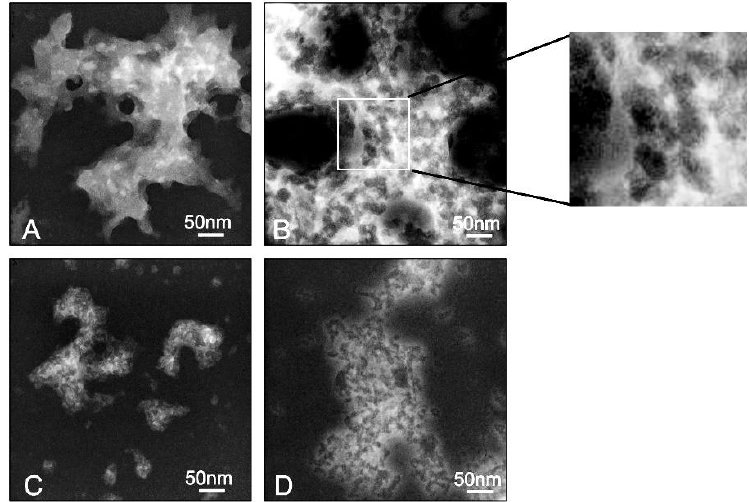
Figure 5. Ultrastructure of G n -[Cu] / siRNA complexes visualised by TEM: ( A ) G 1- [Cu(ONO 2 ) 2 ] 4 , ( B ) G 2- [Cu(ONO 2 ) 2 ] 8 ( C ) G 1- [CuCl 2 ] 4 , ( D ) G 2- [CuCl 2 ] 8 .